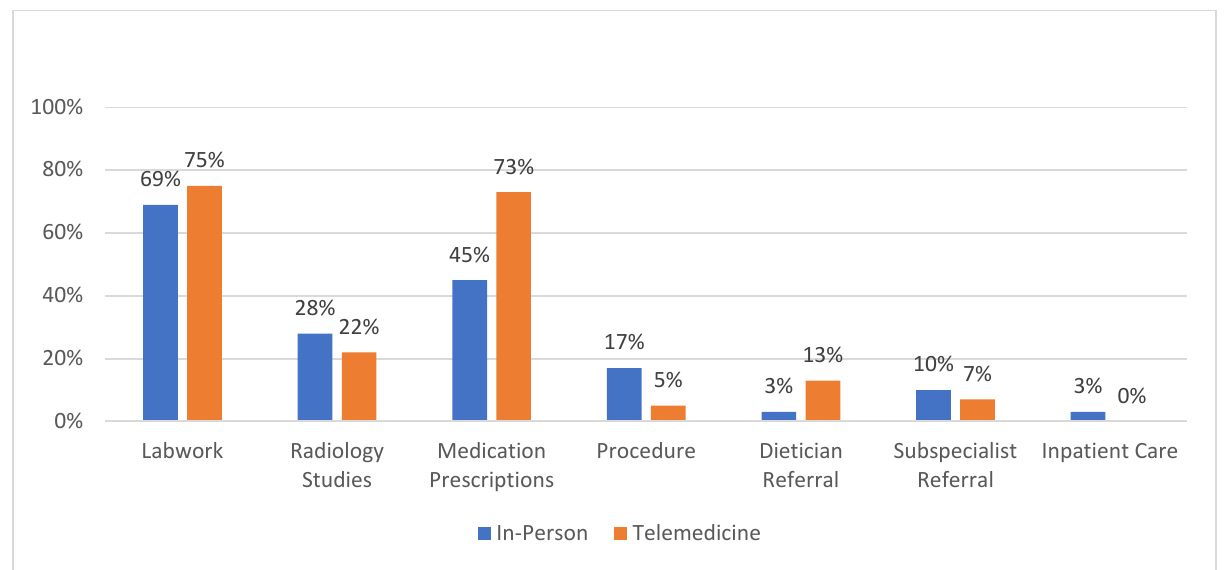
Figure 1. Comparison of work-up and management between patients seen in-person and via telemedicine. Table 3. Primary diagnosis of new patients seen in pediatric gastroenterology outreach clinics.